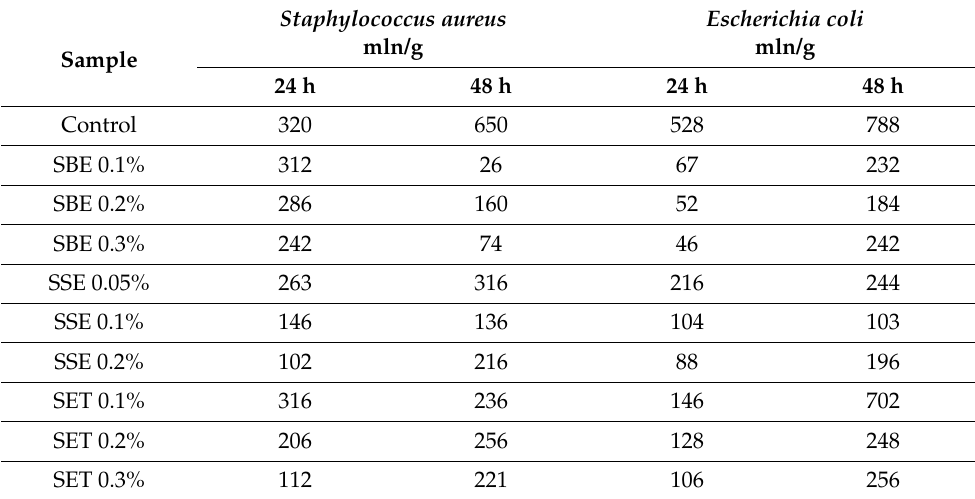
Table 4. The results of in situ monitoring of growing pathogenic